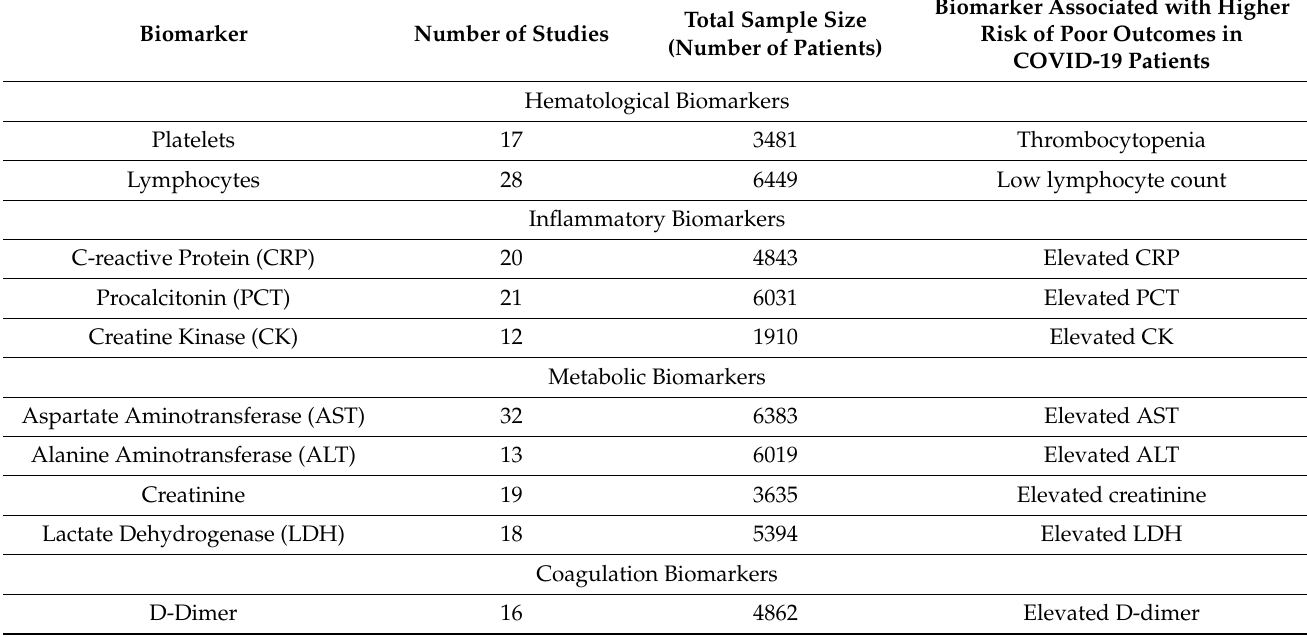
Table 1. Biomarkers and outcomes in patients hospitalized with COVID-19 (Reference